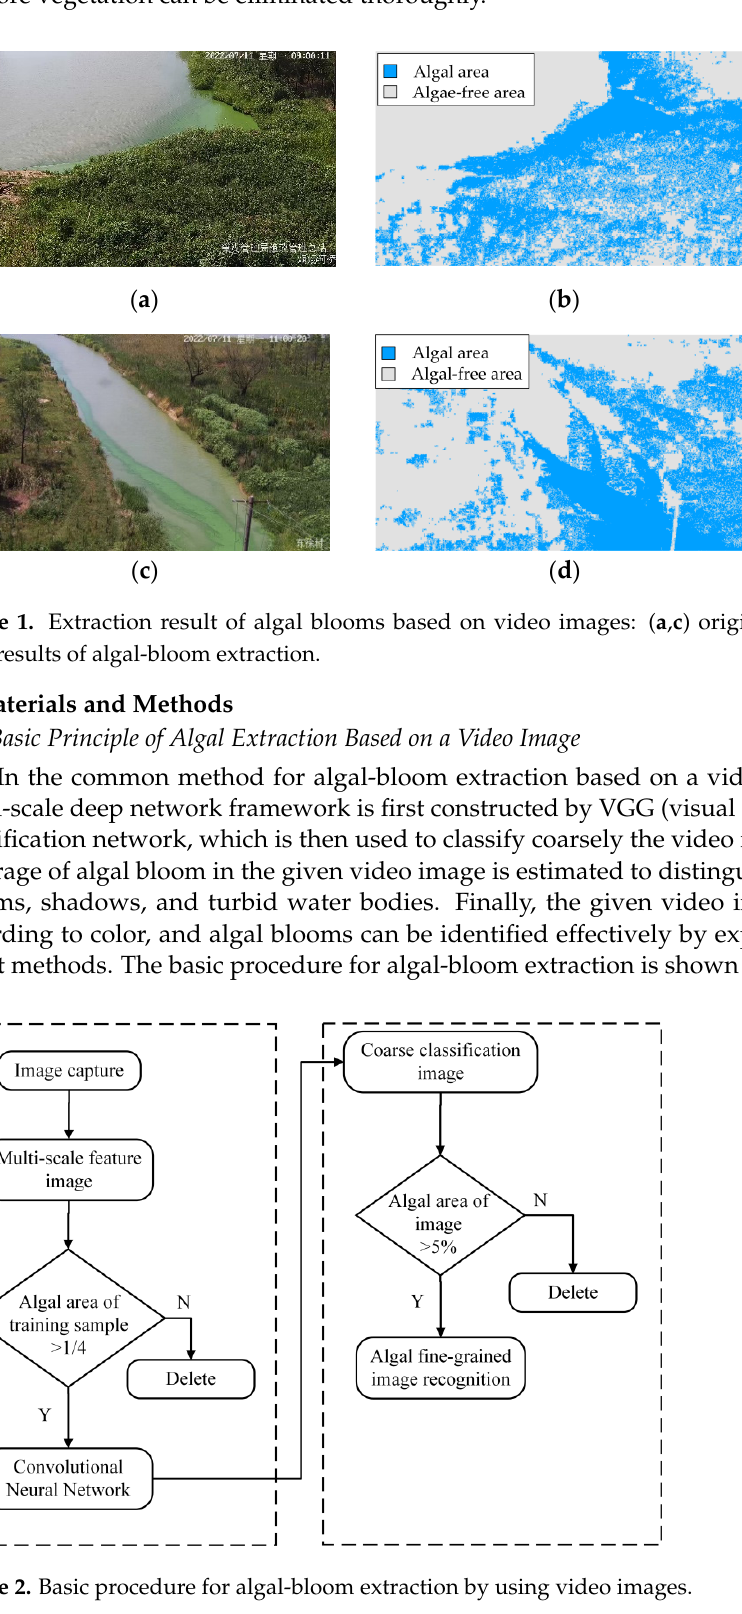
Figure 2. Basic procedure for algal-bloom extraction by using video images.